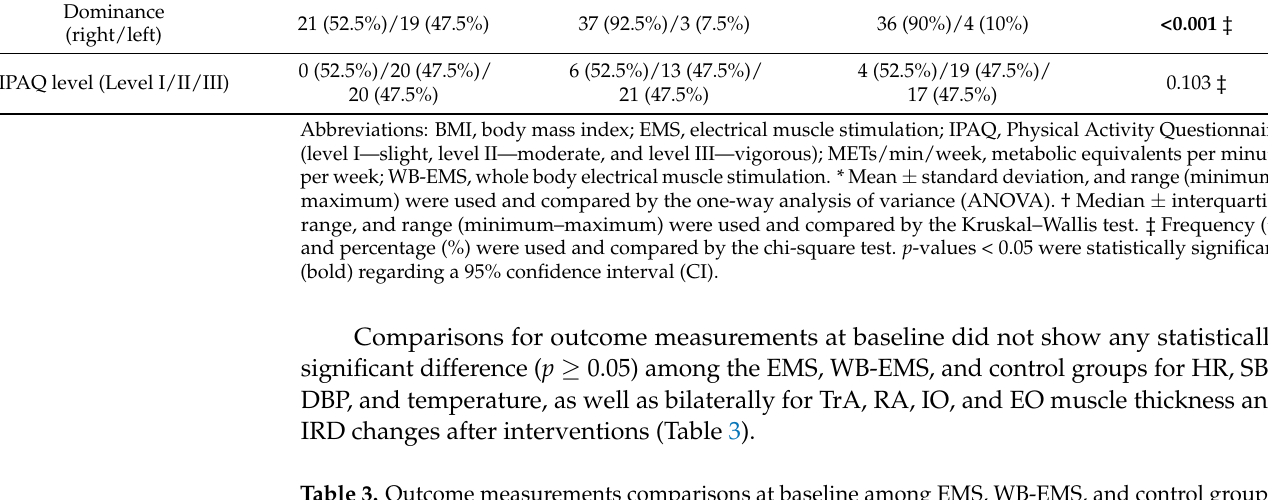
Table 3. Outcome measurements comparisons at baseline among EMS, WB-EMS, and control